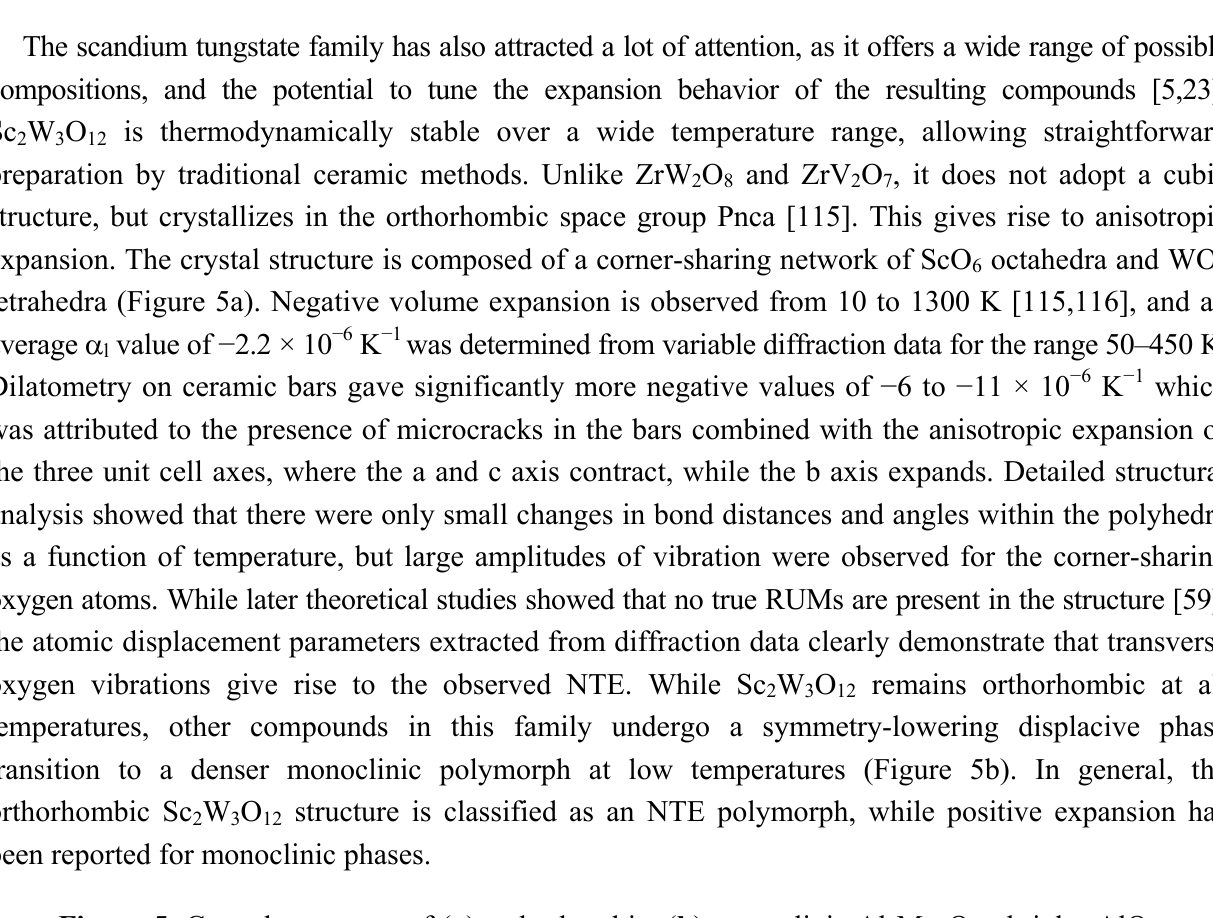
Mo O ; bright: AlO 2 3 12